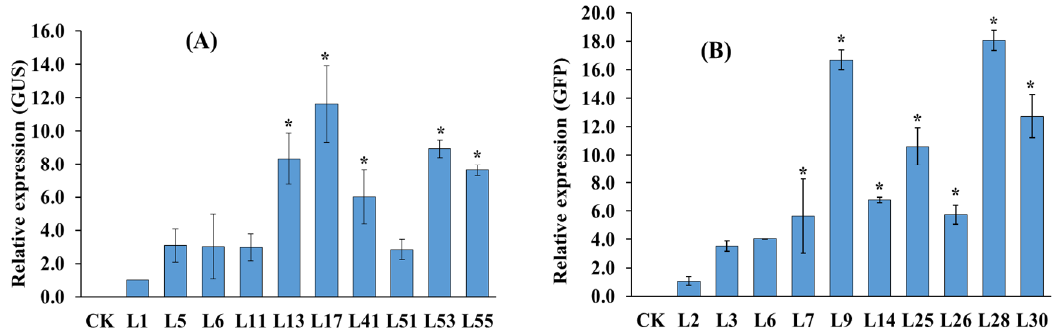
Figure 4. Relative expression assays of ( A ) GUS and ( B ) GFP genes by qRT-PCR in transgenic and non-transgenic (CK) plant leaves. Data are the mean ± standard deviation (SD) ( n = 3), the measured values during the first transgenic line L1 and L2 were set to 1, *: indicates values which are significantly different from the first transgenic line value (ANOVA, p ≤ 0.05), relative expression was calculated by 2 −ΔΔCT method.